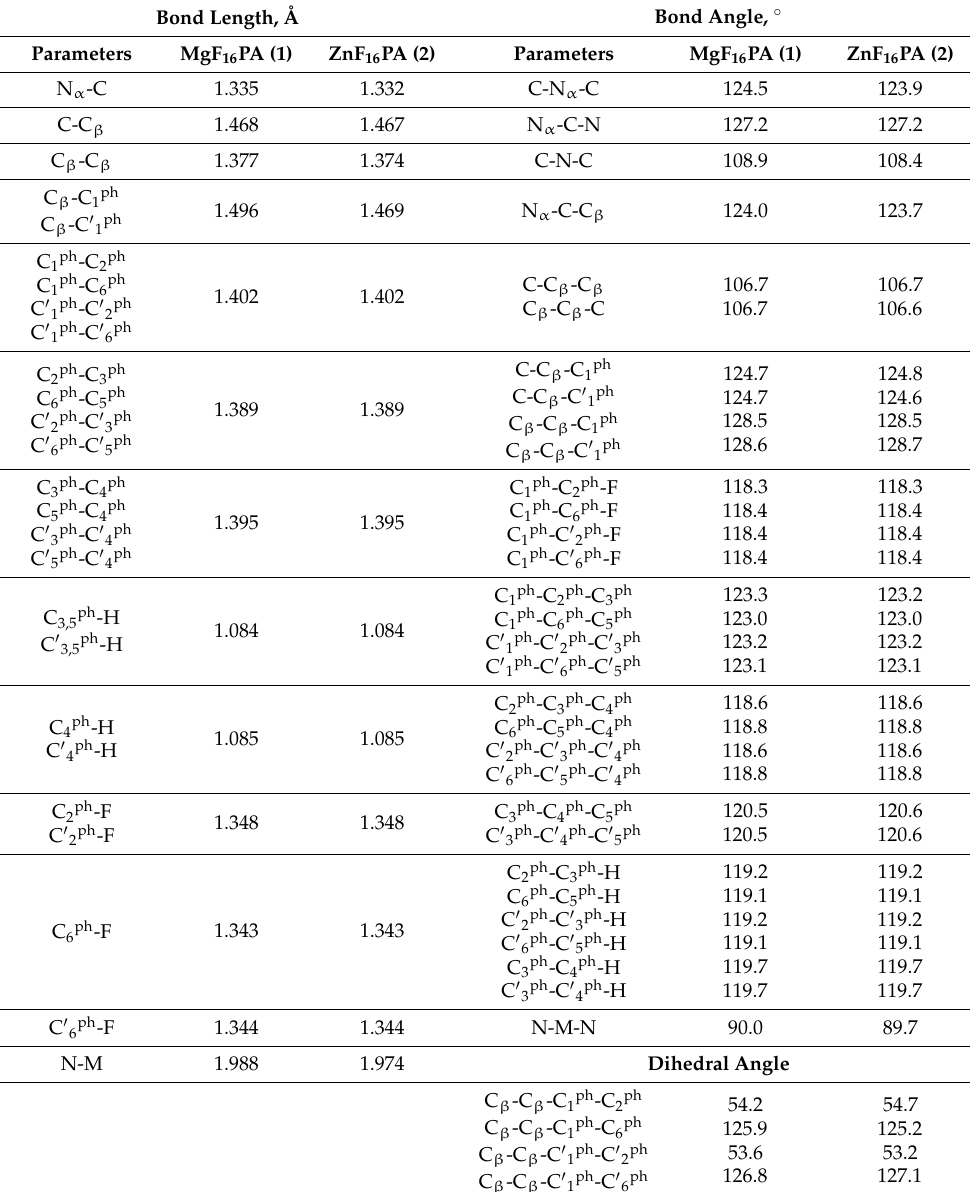
Table 3. Geometrical parameters of magnesium and zinc complexes with ortho -substituted octaphenyl-